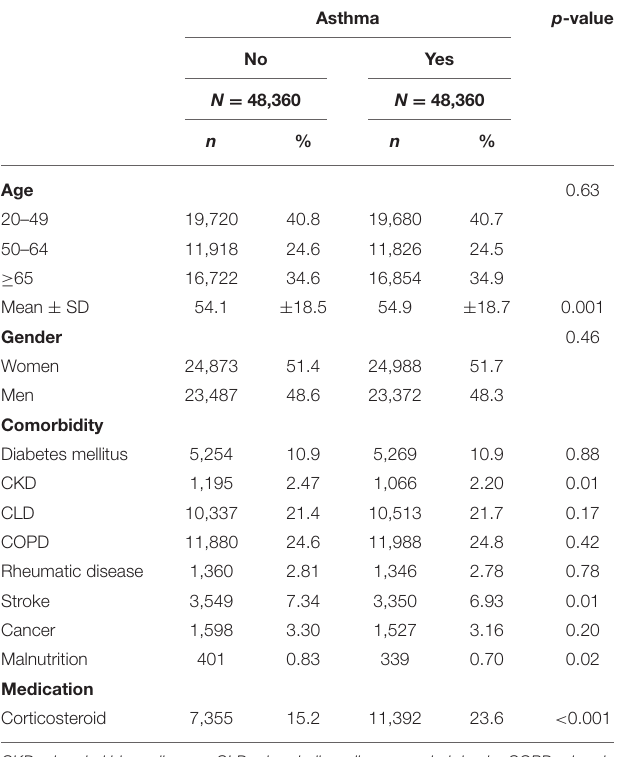
TABLE 1 | Baseline characteristics between asthma and non-asthma cohorts. Asthma p -value